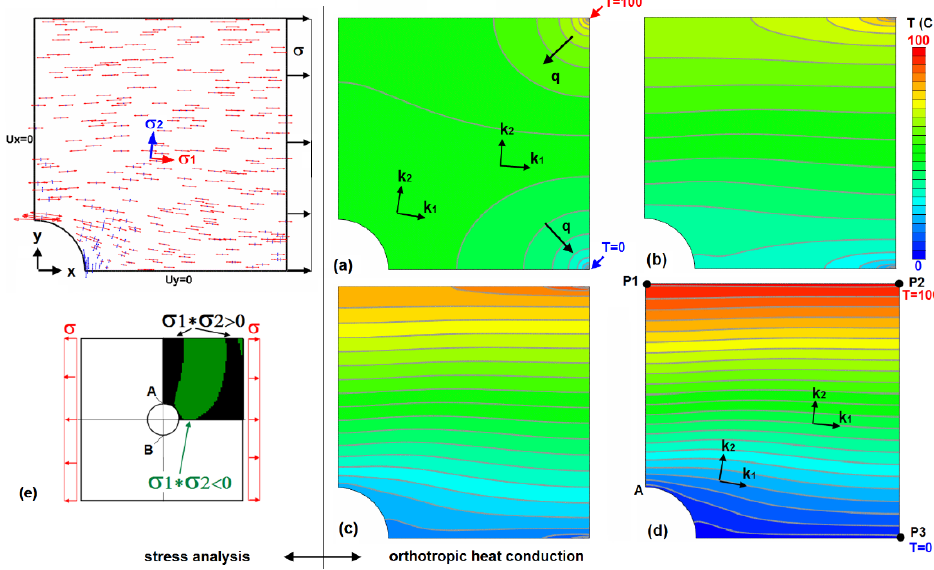
Figure 7. Perforated disc under axial tension and calculation of the PS lines (isotherms) dependent on heat conduction orthotropy k 1 /k 2 , where the orientation of k 1 and k 2 corresponds to the PS directions σ 1 and σ 2 : ( a ) k 1 /k 2 = 1; ( b ) k 1 /k 2 = 16; ( c ) k 1 /k 2 = 128; ( d ) k 1 /k 2 = 4096; ( e ) algebraic signs of the two principal stresses; this point is addressed in Section 3.4.